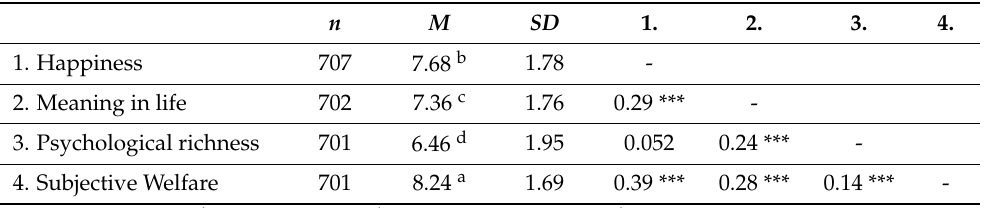
Table 1. Descriptive statistics and correlations for individuals’ importance ratings of wellbeing and subjective